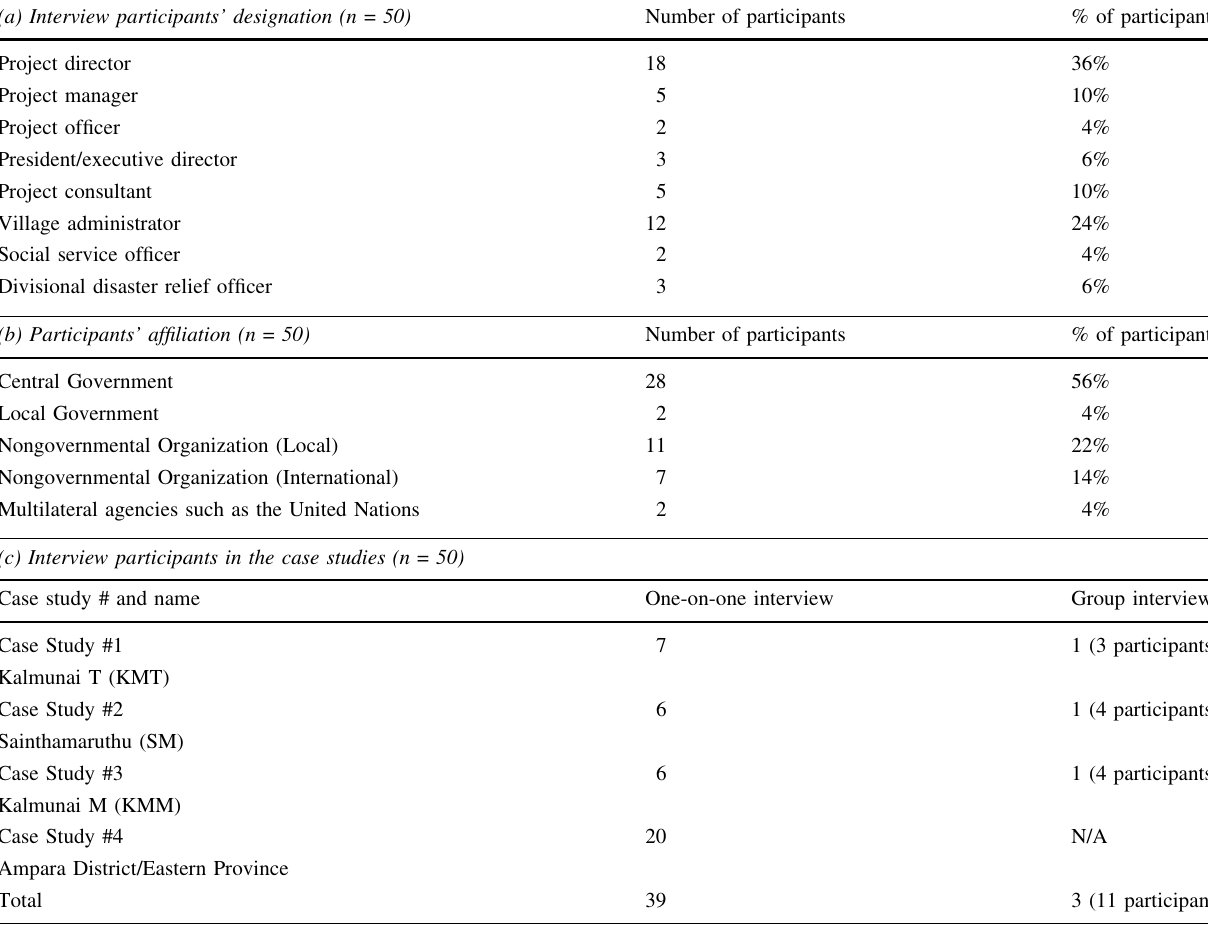
Table 2 Interview participant profiles: (a) designation/position, (b) affiliation, (c) breakdown of interview participants per case study in Sri